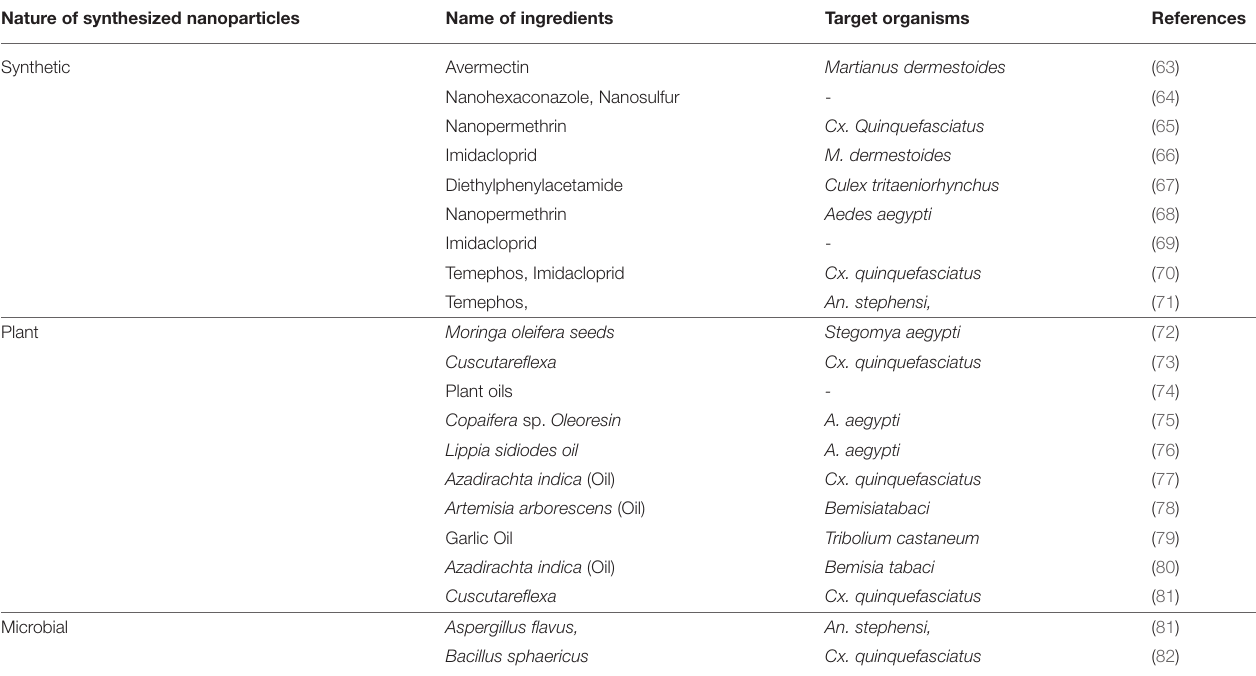
TABLE 3 | List of various encapsulated nanopesticides used against insect pest